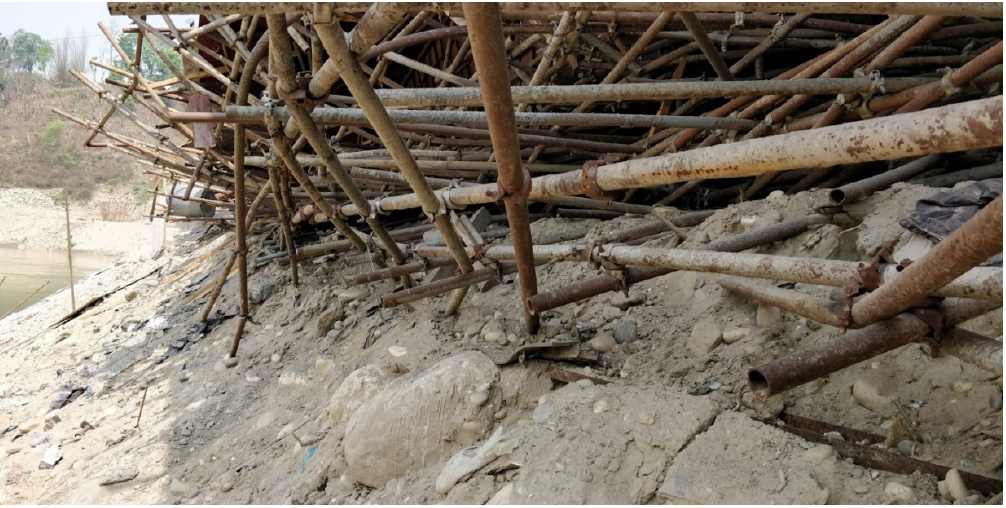
Figure 28. Settlement of downstream-most steel-section league-supporting falseworks.